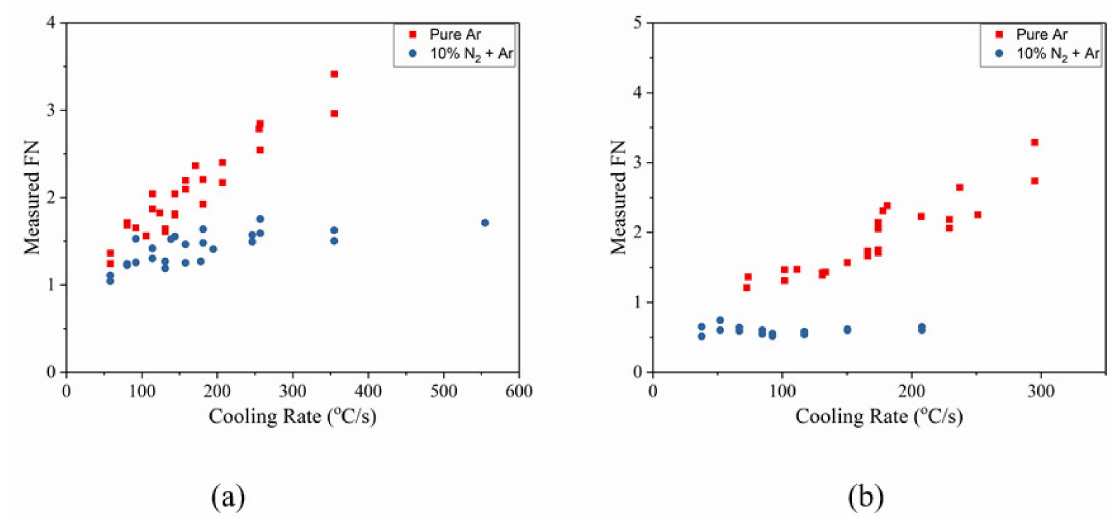
Figure 13. Calculated ferrite density number (FDN) of the welds made on ( a ) 0.7 mm thick sheets; ( b ) 0.9 mm thick